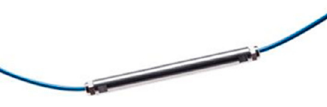
Figure 3. Reinforcement scheme of the 200 × 300 mm beam and application point of the loading steps.